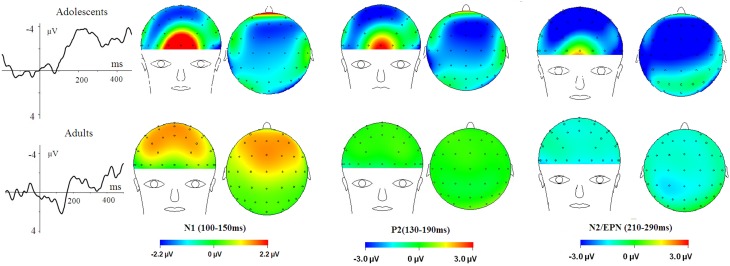
HN–Neutral difference ERPs at FCz, and the topographical distributions of the voltage amplitudes of HN–Neutral difference ERPs in N1 (100–150 ms), P2(130–190 ms), and N2/EPN(210–290 ms) time interval in adolescents (top panel) and adults (bottom panel).